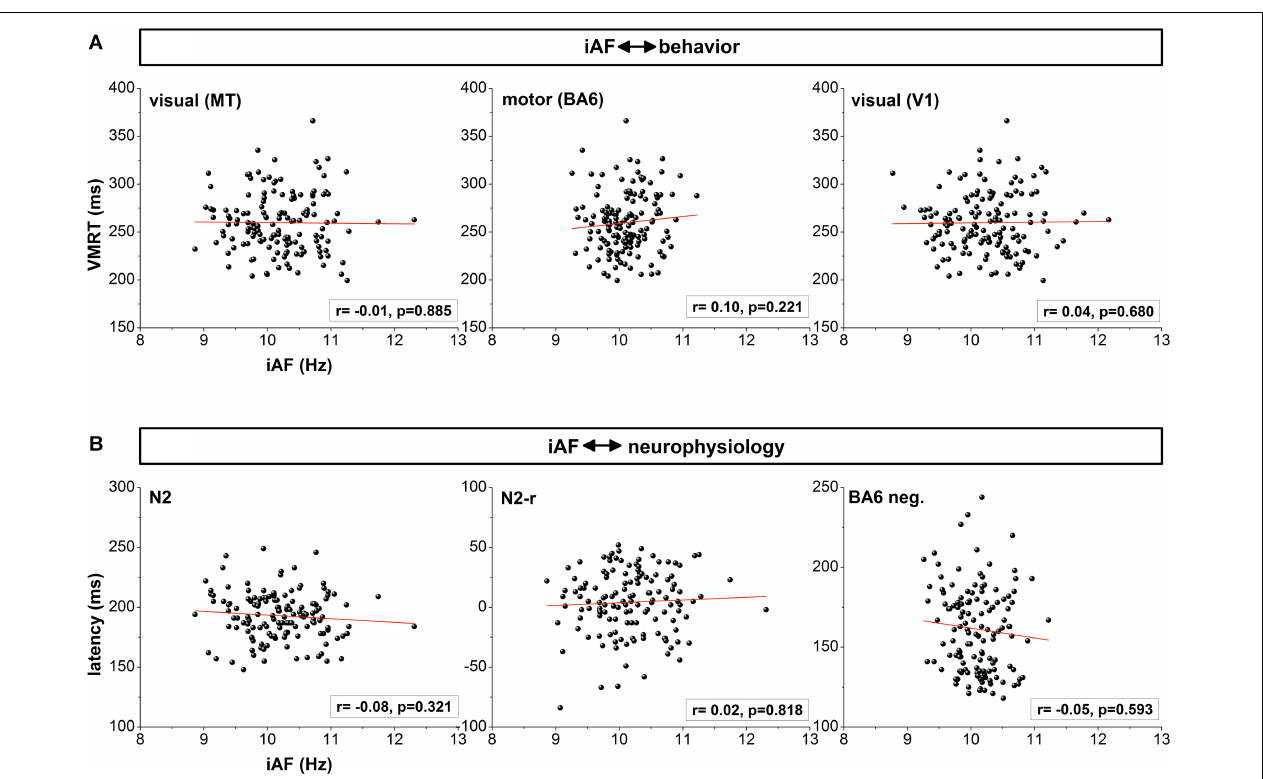
FIGURE 4 | (A) correlation between IAF in visual (MT, V1) and motor [pre- and supplementary motor cortex (BA6)] regions and reaction speed (VMRT). (B) correlation between IAF and latency of event-related potentials corresponding to the motion sensitive visual area MT (N2, N2-r) and BA6 (BA6 negativity). For correlations with the N2 and N2-r latency, IAF was determined for electrode positions corresponding to area MT. For BA6 negativity correlations, IAF was calculated in electrodes related to